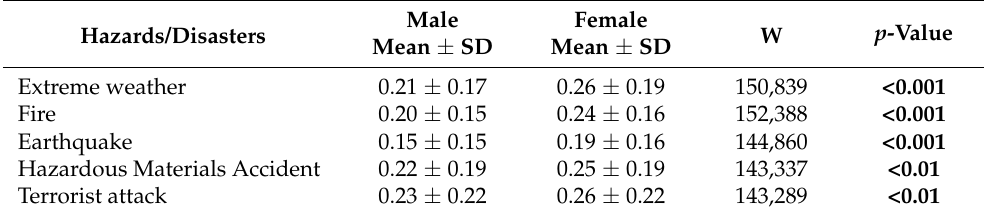
Table 5. Differences in overall risk perception according to gender. Normalized Mean scores, SD standard deviation [0, 1]. p -values of the two-sided Wilcoxon rank sum test. The significant p -value is in